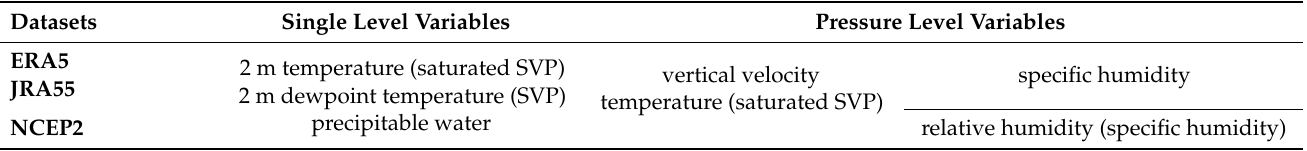
Table 1. The variables directly downloaded from the servers. The variables that need calculation are in brackets, and the variable in each pair of brackets is calculated with the corresponding variable out of the